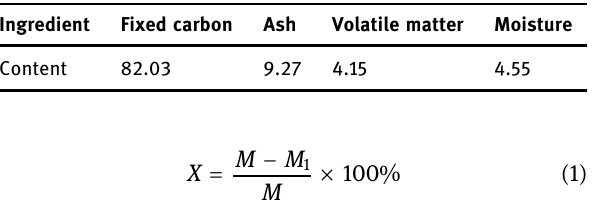
Table 2: Main chemical composition of fl y ash % ( wt )